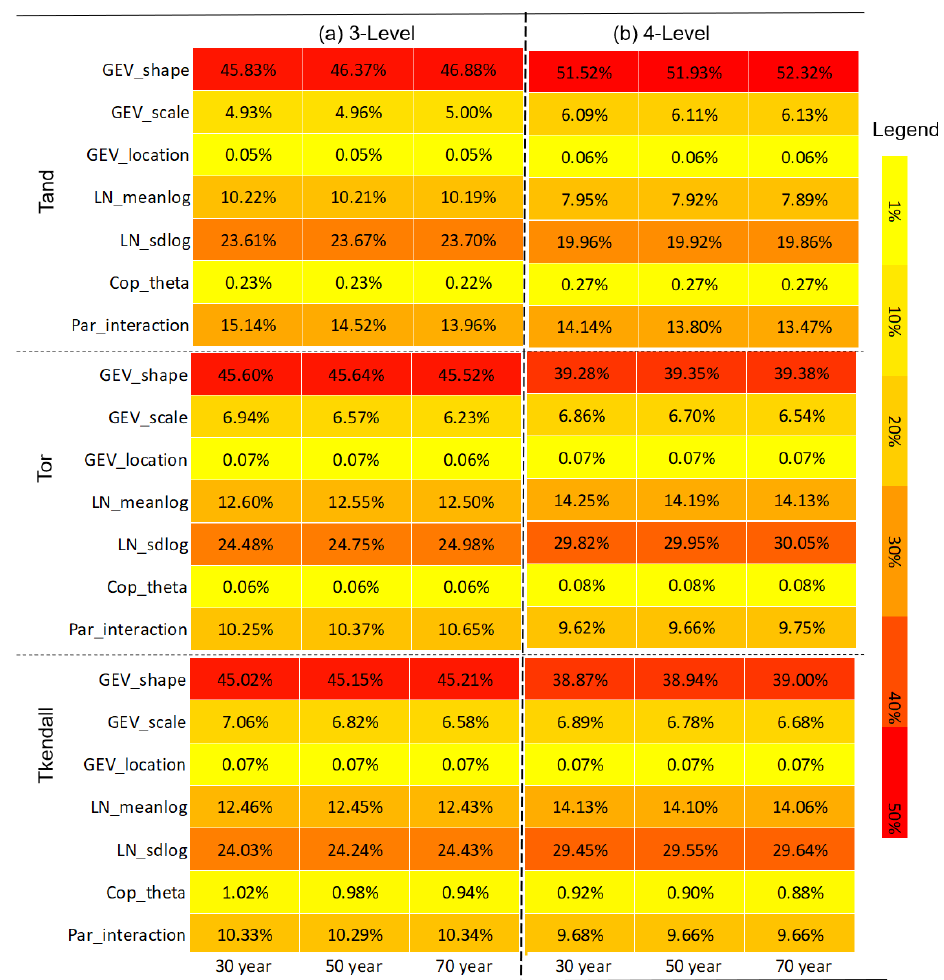
Table 10. Comparison of parameter contributions to predictive uncertainty for failure probabilities under different levels of subsampling for the Zhangjiashan station: three (i.e. 0.1, 0.5, 0.9) and four (i.e. 0.1, 0.35, 0.6, 0.85) level quantiles are adopted for subsampling and the design return period is 200 years.